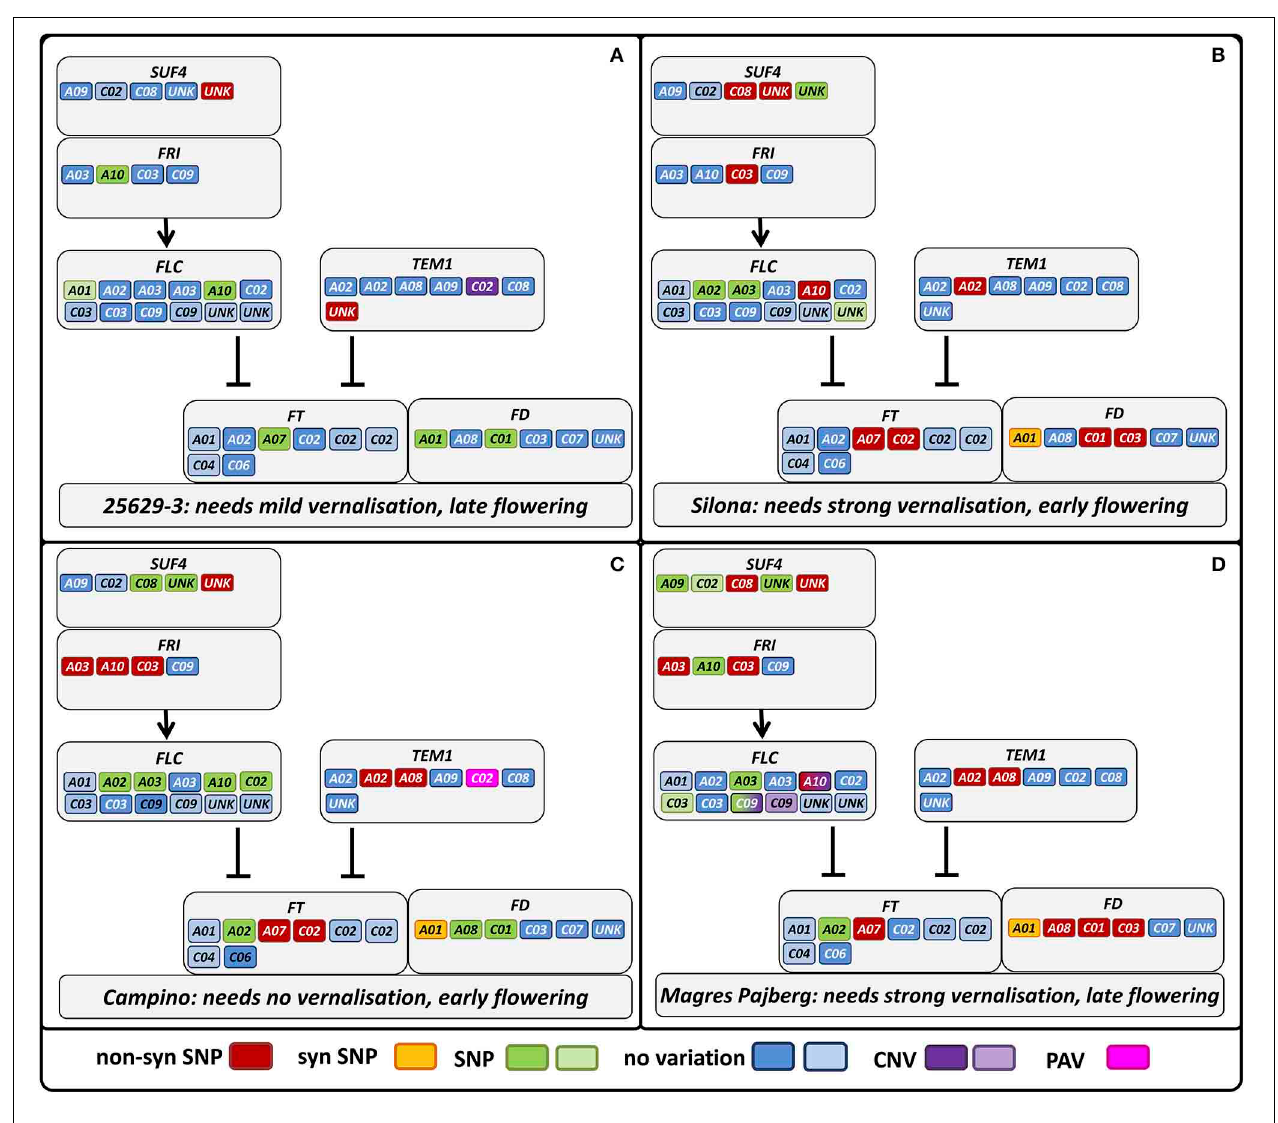
FIGURE 7 | Differential sequence variation in homologs of genes involved in vernalization response among phenotypically divergent B. napus morphotypes. Gray boxes indicate gene interactions in A. thaliana , whereas the colored boxes indicate the respective gene copies in B. napus